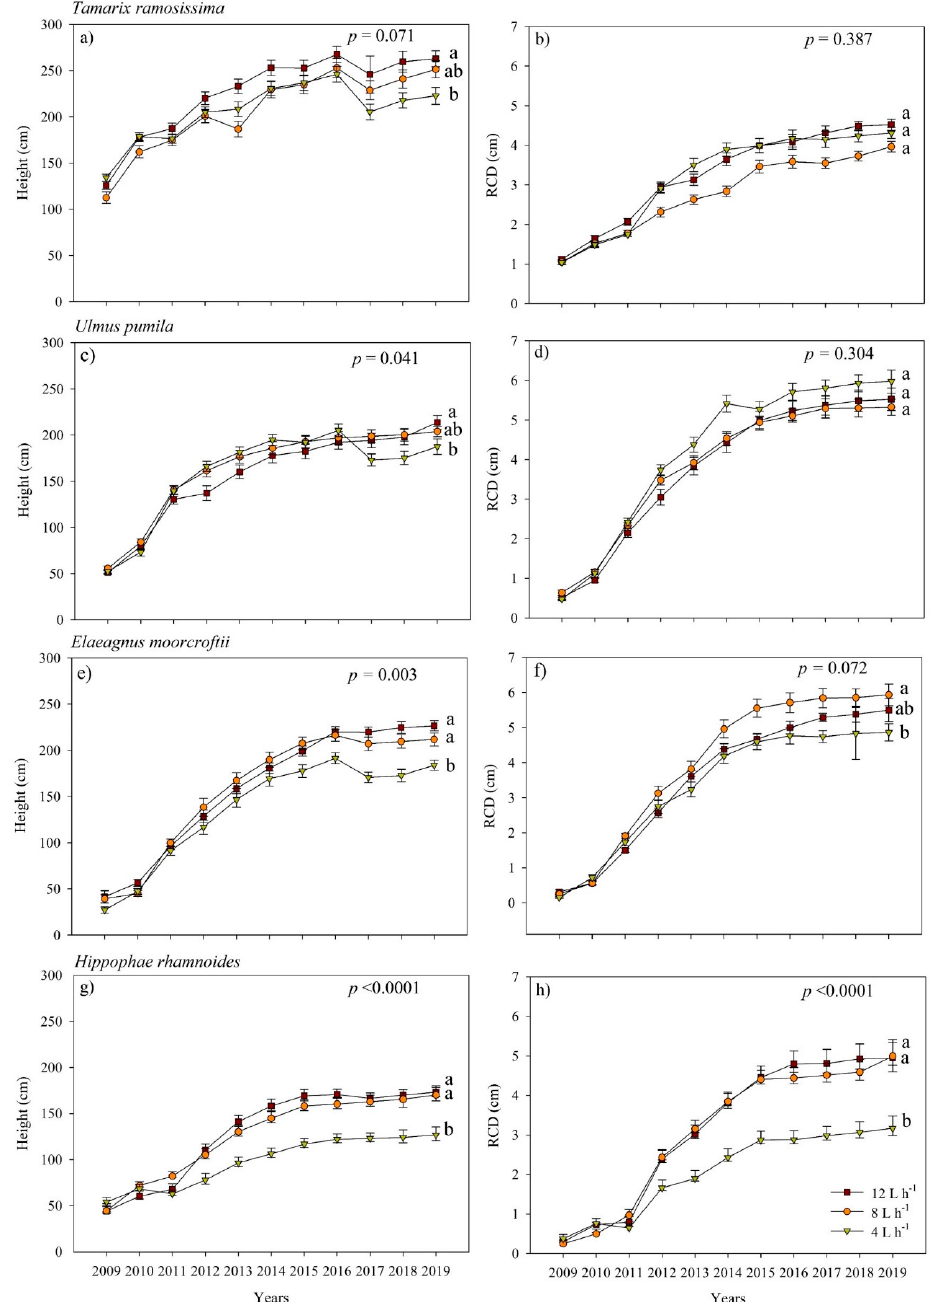
Figure 4. Annual growth pattern of plant height (cm) and root collar diameter (RCD, cm) of ( a , b ) Tamarix ramosissima , ( c , d ) Ulmus pumila , ( e , f ) Elaeagnus moorcroftii , and ( g , h ) Hippophae rhamnoides across irrigation treatments (12, 8, and 4 L h − 1 ). Different lowercase letters within each species indicate significant differences among the treatments at α = 0.05. Vertical bars represent standard errors.